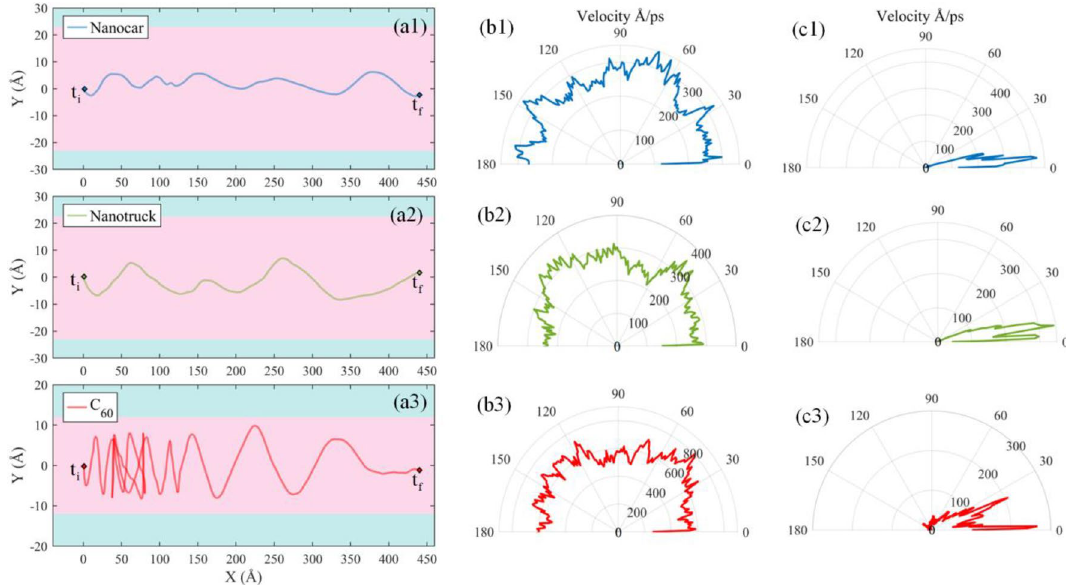
Figure 8. ( a ) Trajectories of nanocar, nanotruck, and C 60 on the nanoroad exposed to the temperature gradient that changes from 600 K (left part of the substrate) to 300 K (right part of the substrate). The blue and pink parts of the figure indicate the graphene and boron-nitride sections of the substrate, respectively. The distribution of absolute values of velocity in different angles with respect to the X-direction for ( b1 ) nanocar, ( b2 ) nanotruck, ( b3 ) C 60 with the constant temperature, and for ( c1 ) nanocar, ( c2 ) nanotruck, and ( c3 ) C 60 with the temperature gradient. It is clear that the horizontal velocity of the molecule’s center of mass is more directional when the thermal gradient is applied to the substrate, and most of the velocity vectors are almost distributed around the positive direction of the